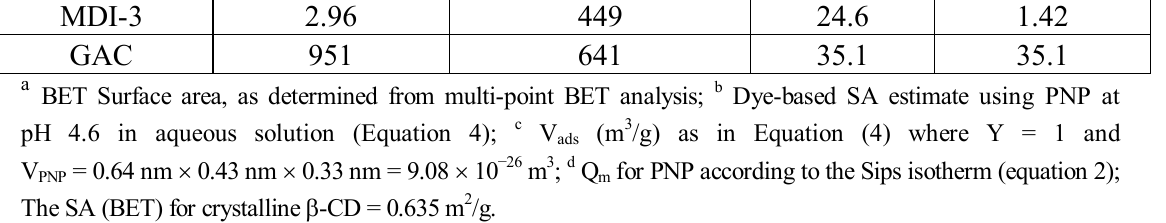
, and Q for the ads m